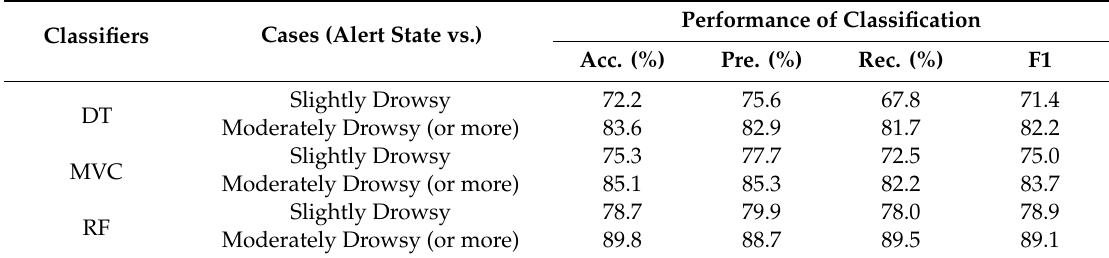
Table 4. Classification results in the case of excluding physiological indices.